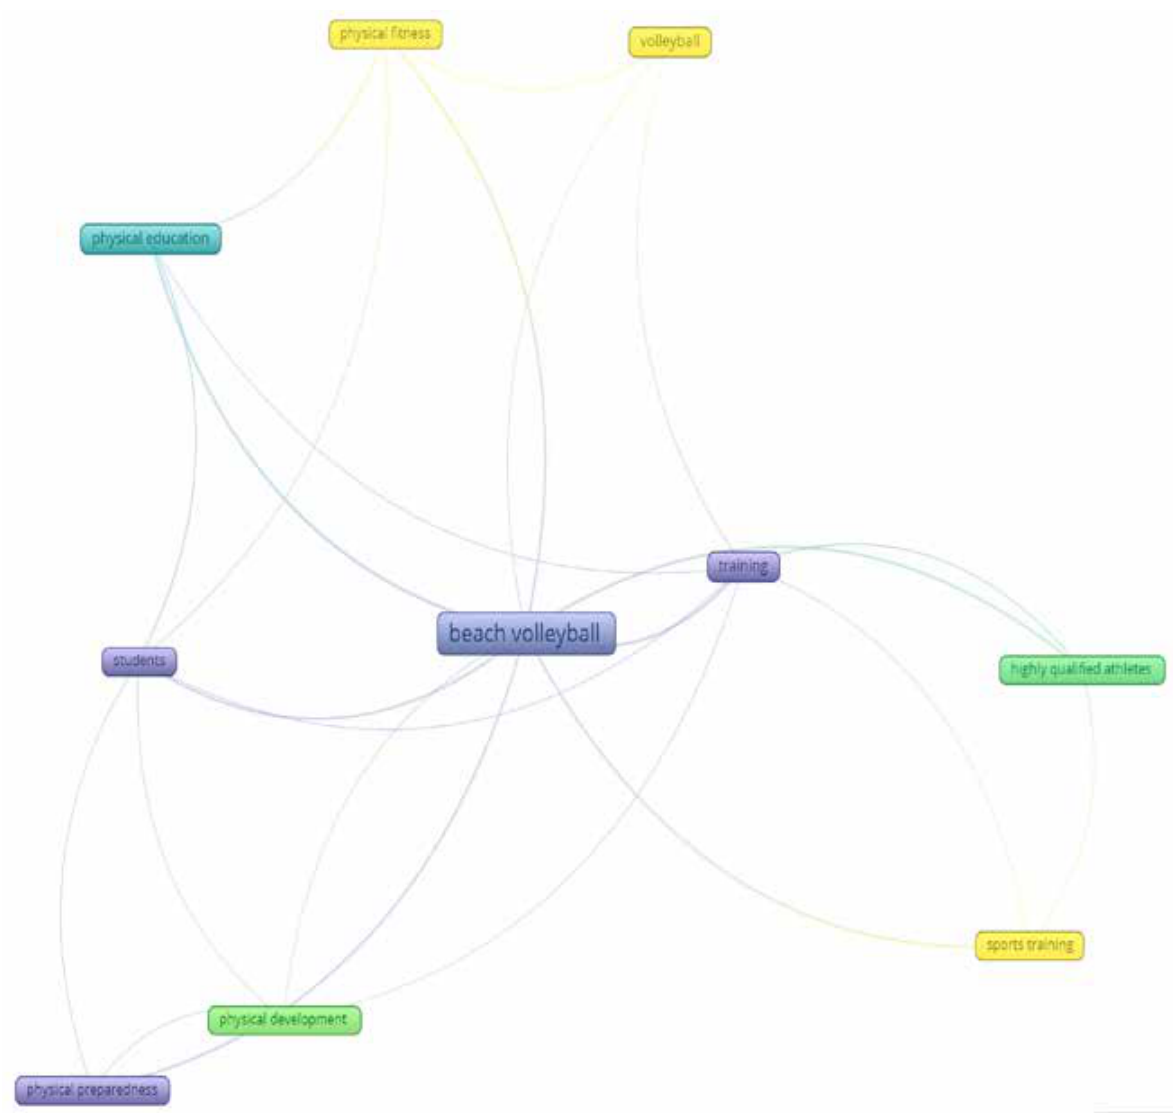
Figure 8. Data visualization of the relationship of 10 keywords (source: own research based on extracted data from the SEL database and analyzed with VOSviewer;